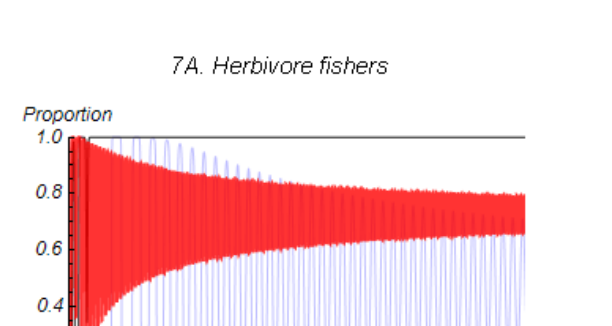
Fig. 7 . Simulation results reflecting changes in fishers/km² showing time-series plots for fishers (7A) and profit differentials (7D), and parametric plots for fish (7B) and for coral and algae (7C). The dots represent initial